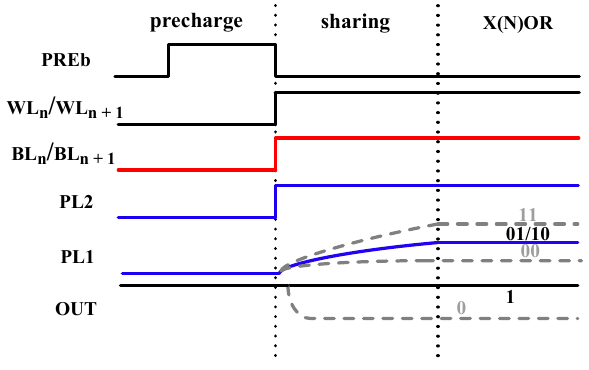
Figure 8. Timing of X(N)OR.